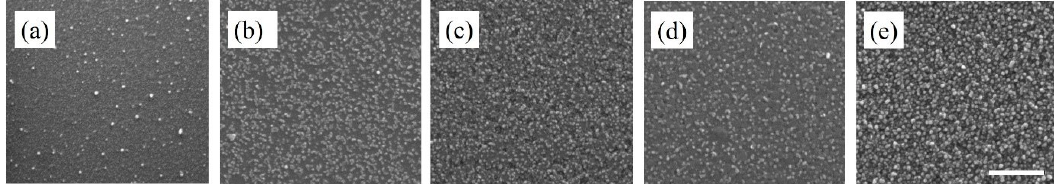
Figure 6. SEM images of Cu-based nanostructures deposited on Si substrate after ( a ) first, ( b ) second, ( c ) third, ( d ) fourth, ( e ) fifth deposition cycle with L-Cys added as surfactant. The scale bar is 500 nm. Nanomaterials 2020 , 10 , x FOR PEER REVIEW 7 of 15